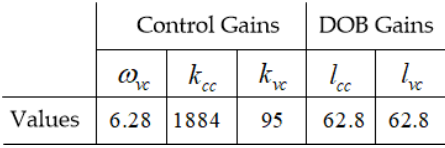
Figure 4. Simulation parameter summary